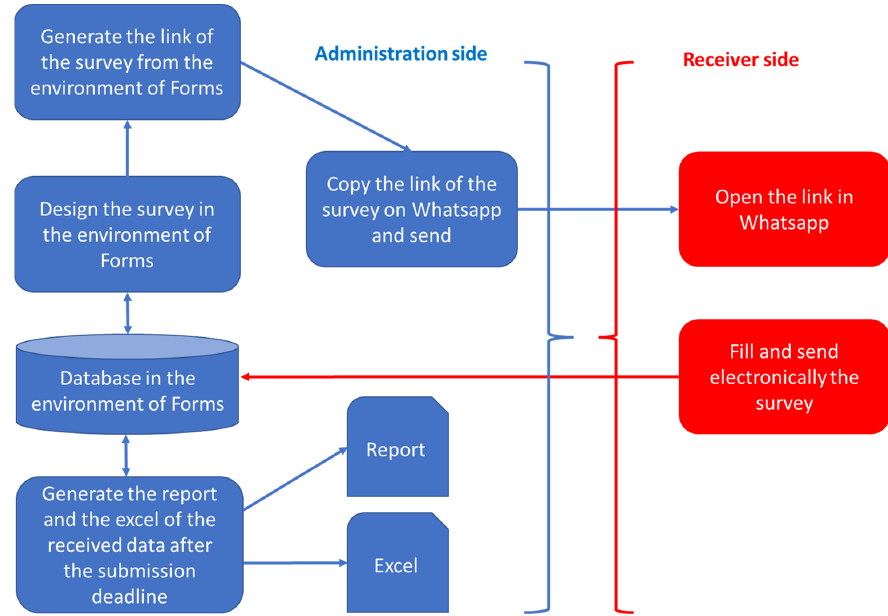
Figure 1. An example of the submission flow based on a possible applicable tool (WhatsApp).